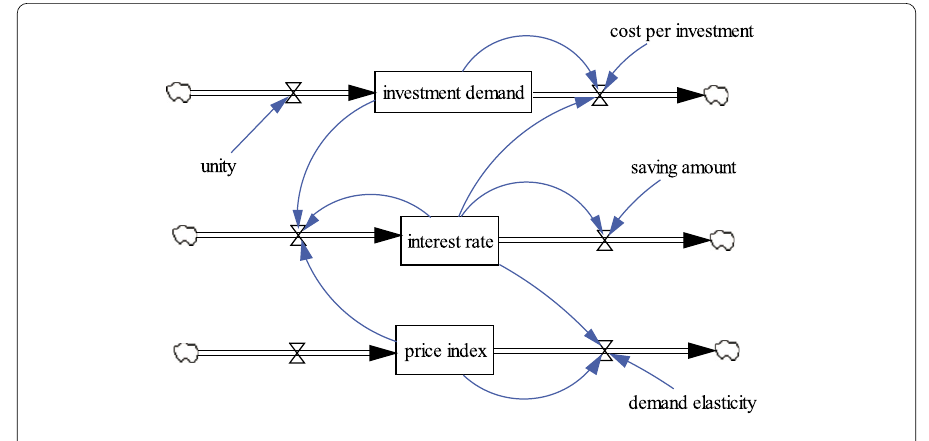
Figure 1 Schematic diagram of a simple financial system